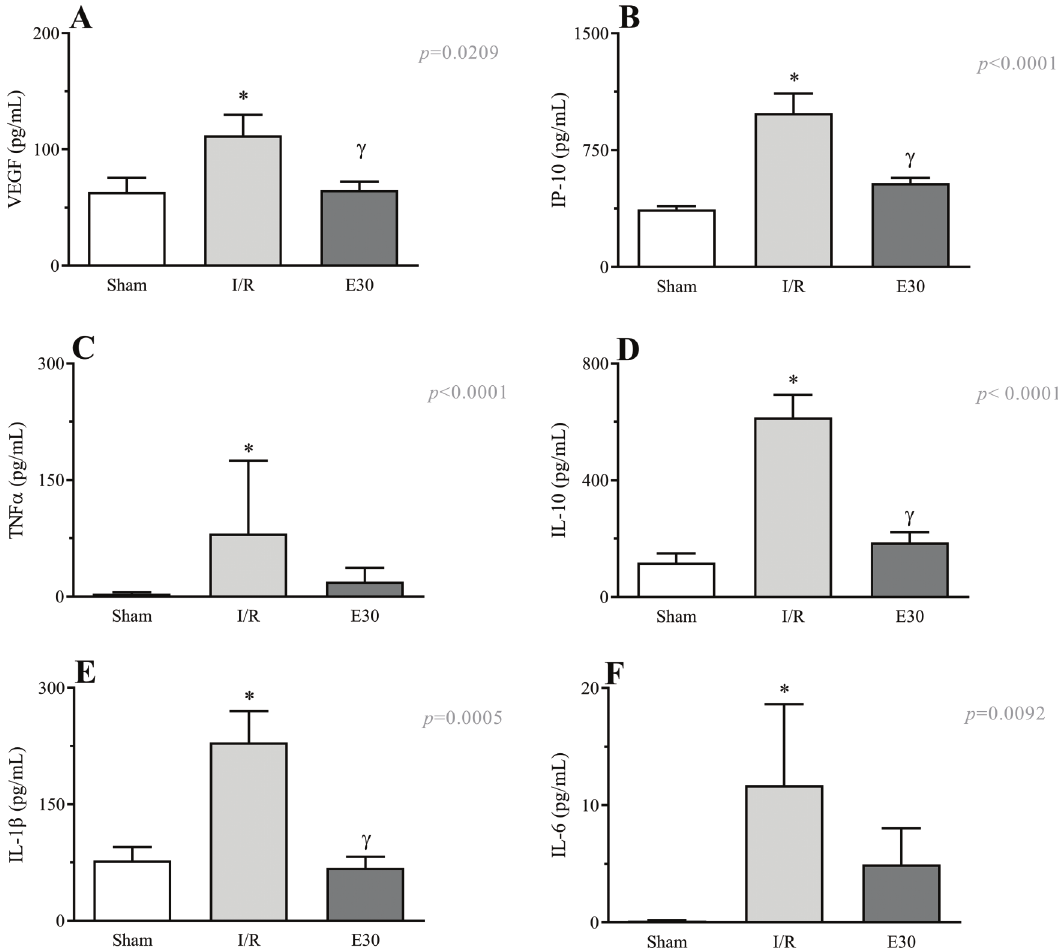
Figure 6 - Effects of intestinal I/R injury and estradiol treatment on the serum levels of VEGF (panel A), IP-10 (panel B), TNF a (panel C), IL- 10 (panel D), IL-1 b (panel D), and IL-6 (panel E). In I/R injury rats, the superior mesenteric artery was clamped (45 min), followed by intestinal reperfusion (2h). Estradiol (180 m g/kg, i.v.) was administered 30 min after induction of intestinal ischemia (E30). Sham- operated rats were used as controls. Data are expressed as the mean ± standard error of the mean (SEM) from 8 animals. * p p 0.05 compared with sham; g p p 0.05 compared with I/R. I/R, ischemia and reperfusion; VEGF, vascular endothelial growth factor; IP-10, inducible-protein-10 IL-10, interleukin 10; IL-1 b , interleukin-1 b ; TNF a , tumor necrosis